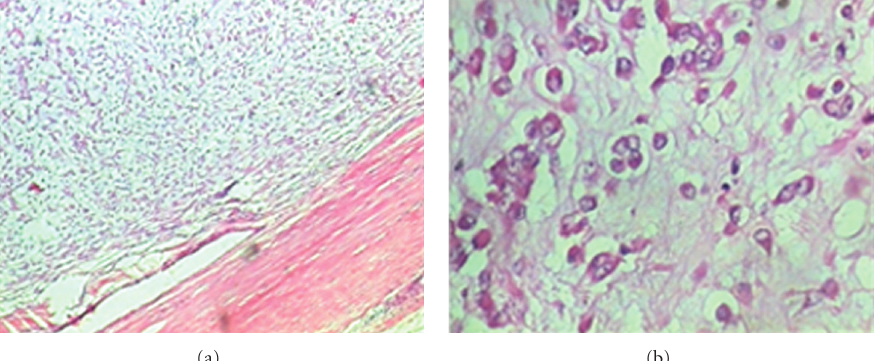
Figure 2: (a) Encapsulated sarcomatous tumor (Hematoxylin & Eosin stain 80X). (b) Single and small groups of vacuolated cells separated by abundant mucoid matrix (Hematoxylin & Eosin stain